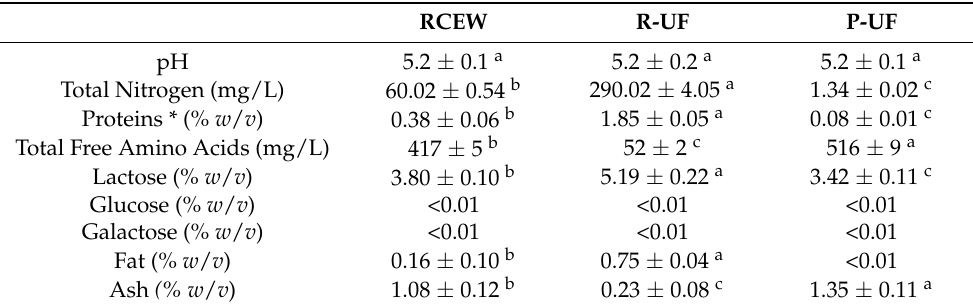
Table 2. Proximal composition of ricotta cheese exhausted whey (RCEW), ultrafiltration protein-rich retentate (R-UF), and ultrafiltration permeate (P-UF).